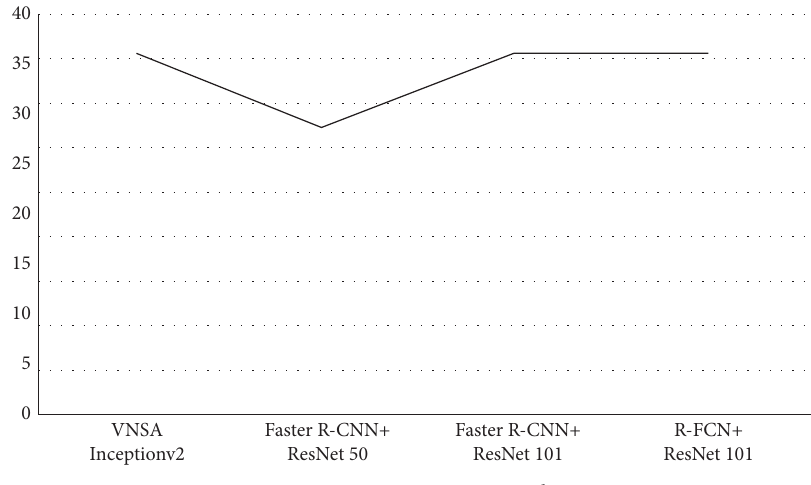
Figure 6: Accuracy comparison on the test